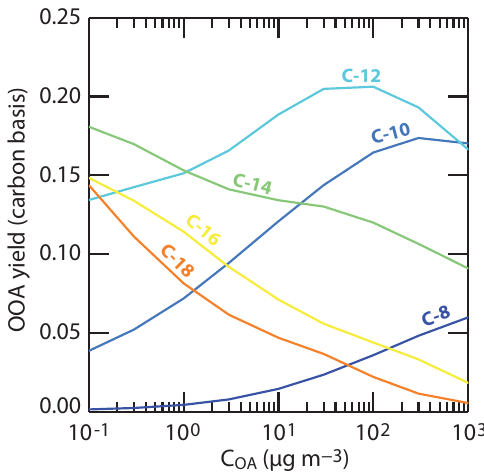
Fig. 8. Yield of highly oxygenated organic aerosol (OOA) for C 8 – C 18 n -alkane as a function of C OA . Yields are computed for an aging time of Figure 8: Yield of highly oxygenated organic aerosol (OOA) for C 8 ‐ C 18 n ‐ alkane as a function of C OA . Yields are computed for an aging time of 5 days.